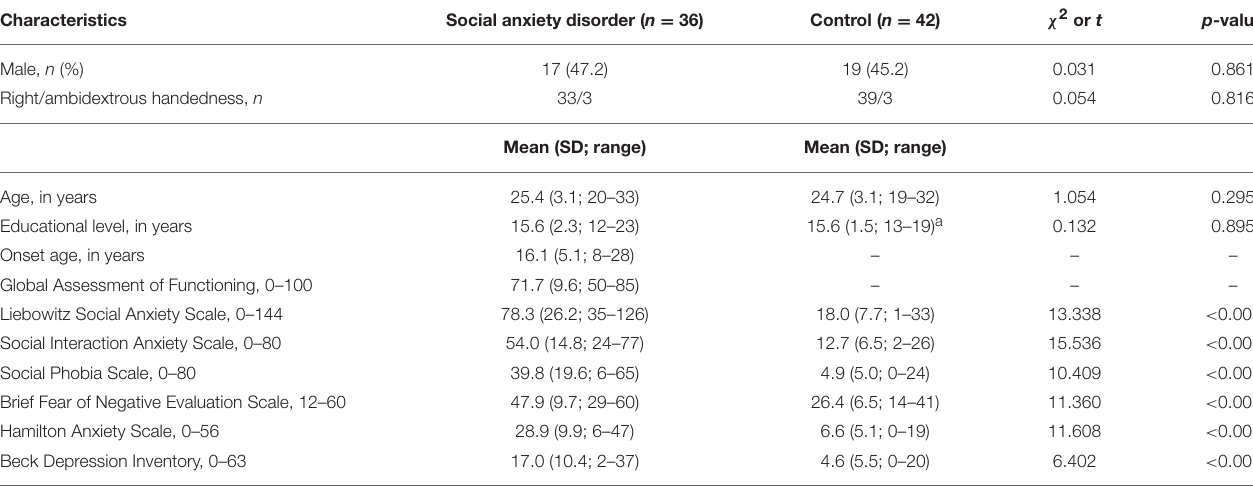
TABLE 1 | Participant demographic and clinical characteristics.